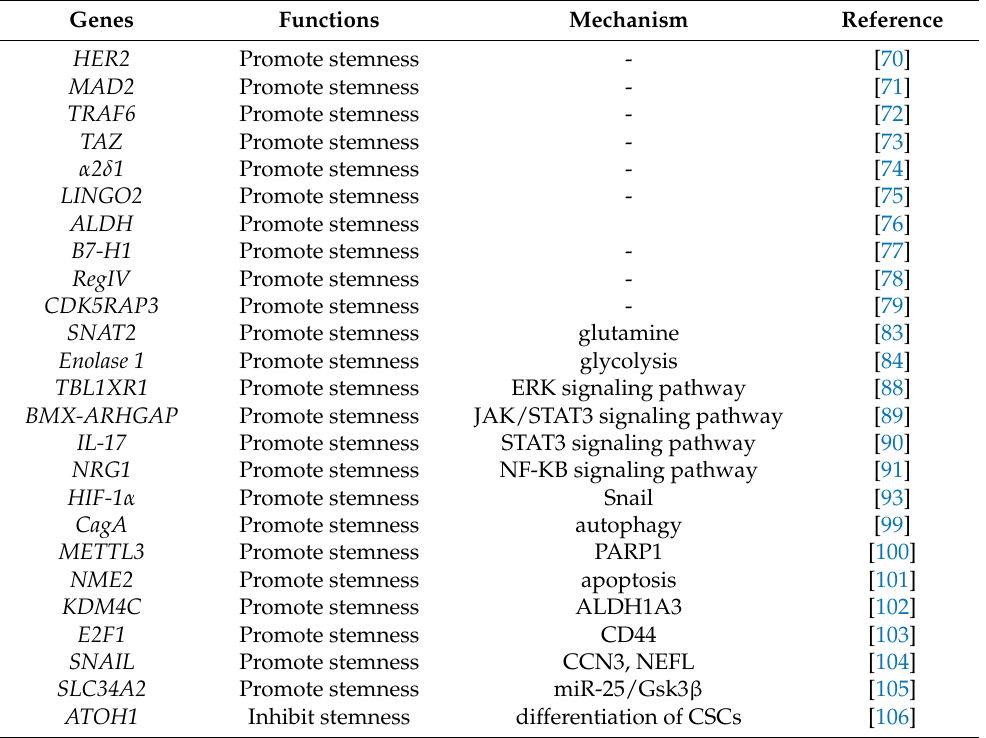
ATOH1 Inhibit stemness differentiation of